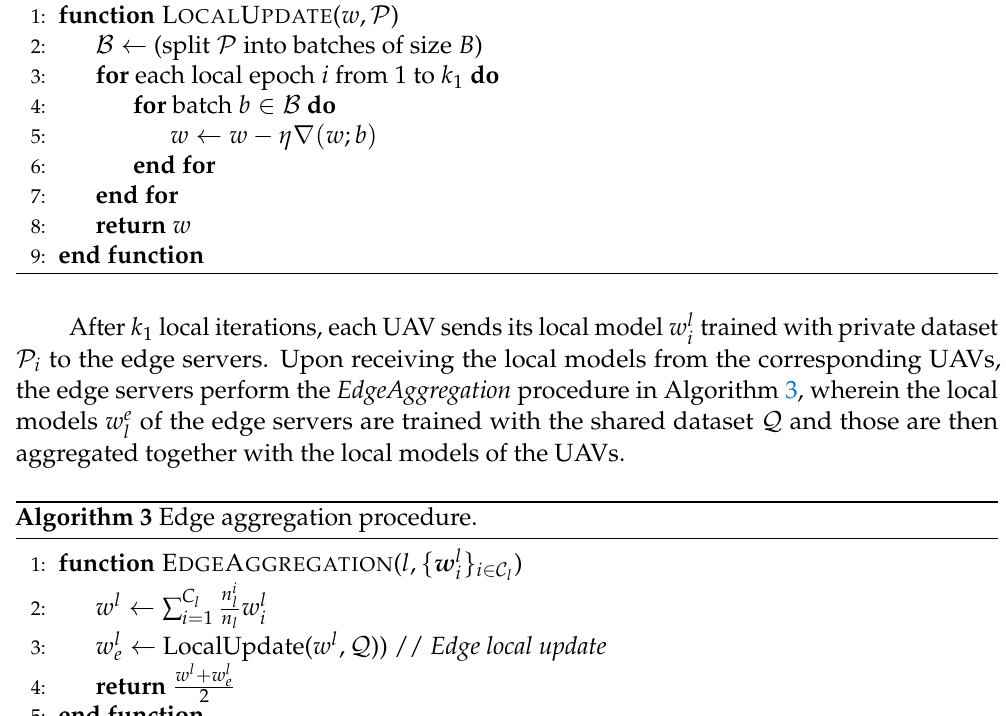
Algorithm 2 Local update procedure.